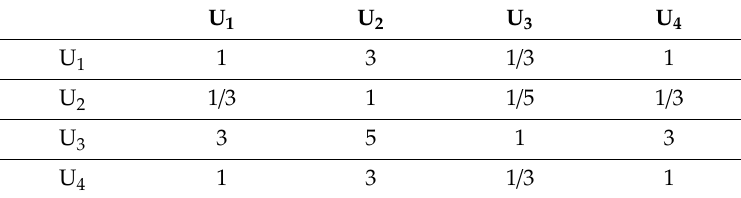
Table 9. Judgment matrix of the safety performance evaluation